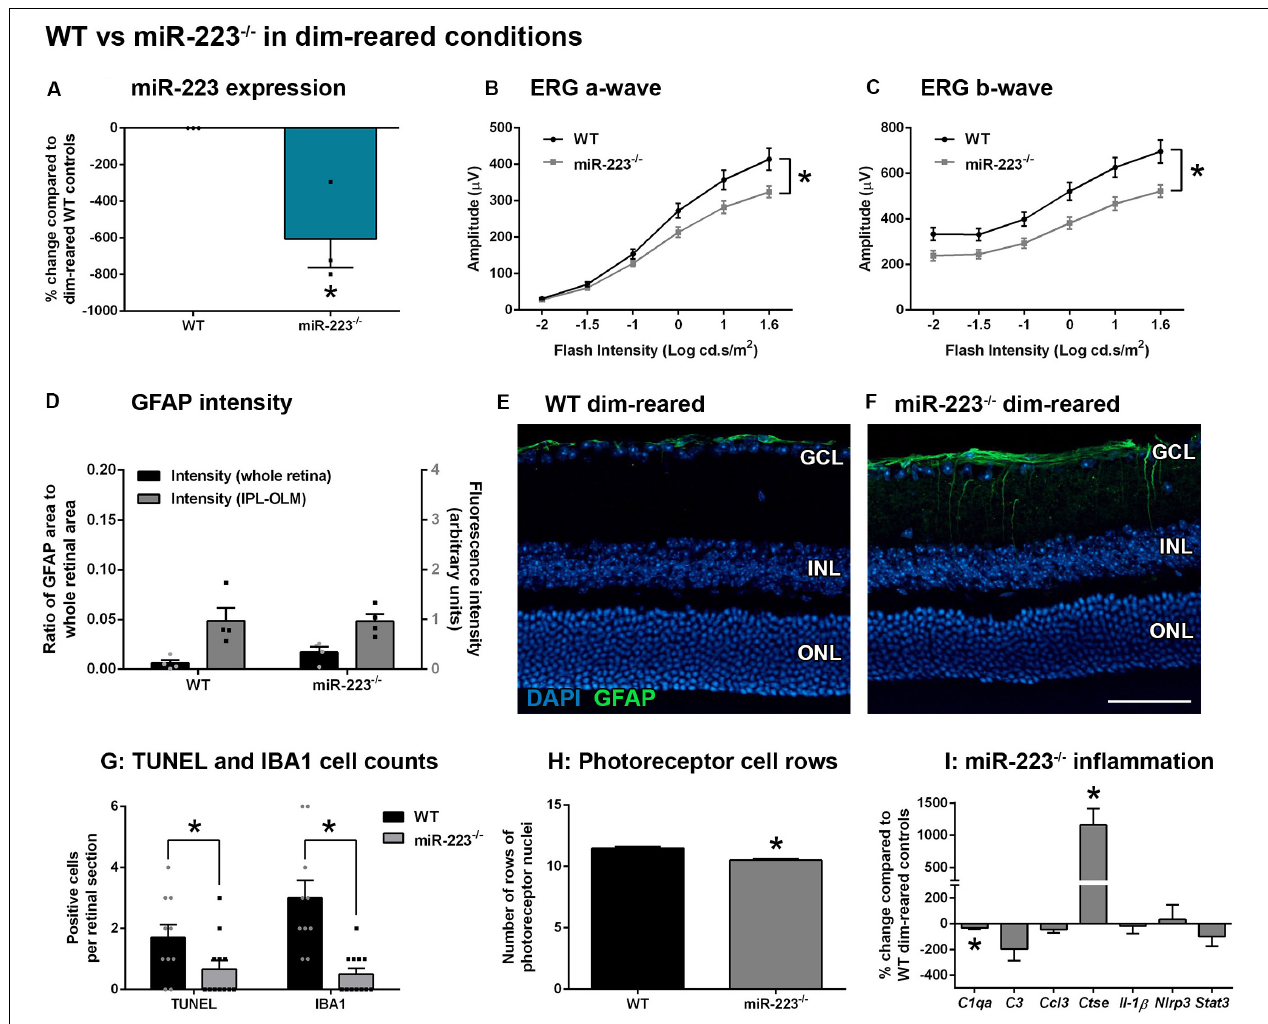
FIGURE 1 | Retinas of wild-type (WT) and miR-223 − / − mice under normal, dim-reared conditions. (A) miR-223 − / − mice were confirmed to have a significant reduction in retinal miR-223 expression compared to WT mice ( P < 0.05). (B,C) Electroretinography (ERG) of the a-wave (B) and b-wave (C) demonstrated that miR-223 − / − mice had reduced retinal function compared to WT controls ( P < 0.05). (D–F) No significant differences in GFAP levels (green) were observed between groups ( P > 0.05). Units for whole retinal GFAP on left Y -axis (black) and units for IPL to OLM GFAP on right Y -axis (gray). (G) TUNEL + and IBA1 + cells were reduced in the outer retina of miR-223 − / − mice compared to WT controls ( P < 0.05). (H) However, miR-223 − / − retinas had more photoreceptor layer thinning than WT retinas ( P < 0.05). (I) C1qa and Ctse retinal expressions were significantly changed in miR-223 − / − retinas compared to WT controls ( P < 0.05). Expression of C3 , Ccl3 , Il-1 β , Nlrp3, and Stat3 were unchanged ( P > 0.05). IPL, inner plexiform layer; OLM, outer limiting membrane; GCL, ganglion cell layer; INL, inner nuclear layer; ONL, outer nuclear layer. Scale bar is 50 µ m. Sample size is N = 3–6. *Denotes significance ( P <